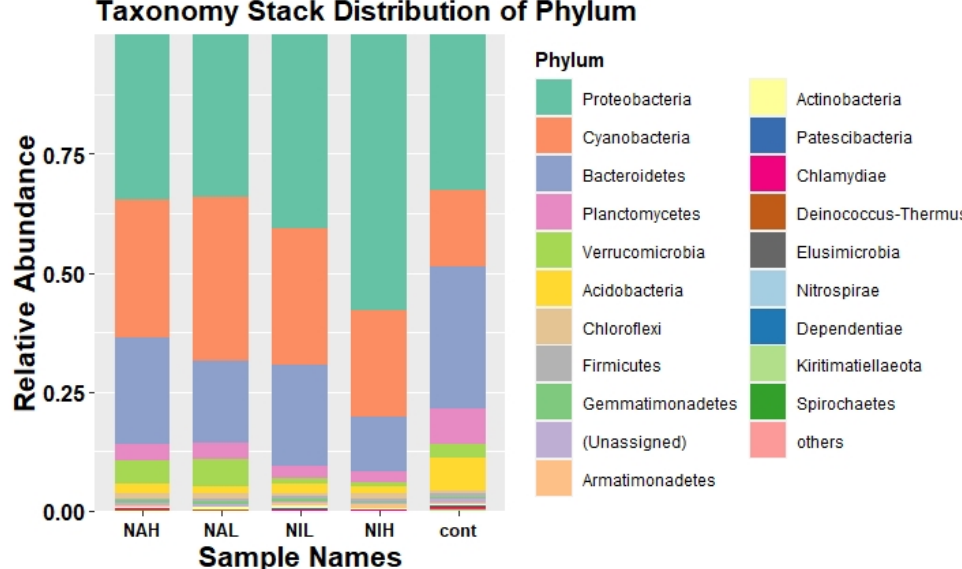
Figure 2. Community composition at the phylum level of the different treatments, selected species with relative abundance greater than 1%. Cont: control; NAH: 1 mg/L sodium selenate); NAL: 100 µg/L sodium selenate; NIH: 1 mg/L sodium selenite; NIL: 100 µg/L sodium selenite.